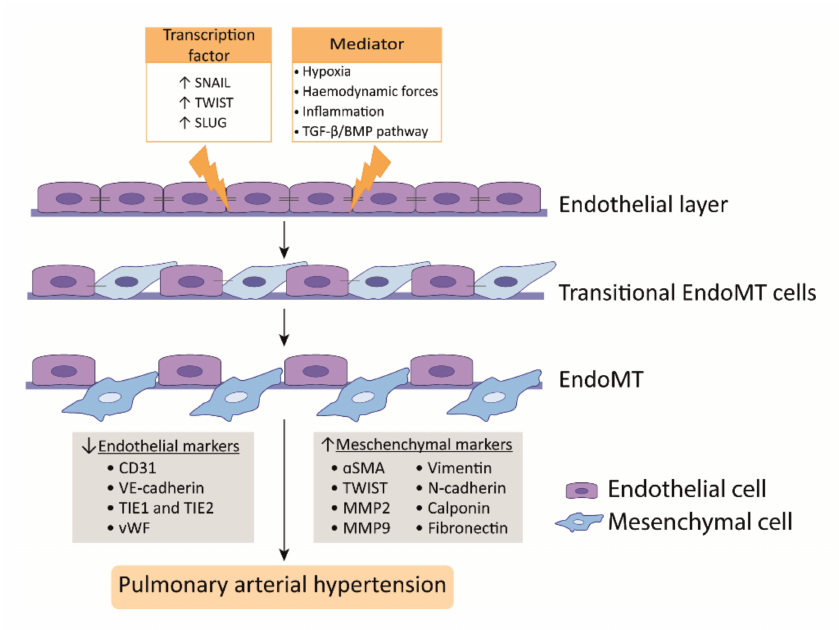
Figure 4. Endothelial to mesenchymal transition (EndoMT) in PAH. EndoMT in PAH is thought to be an important process contributing to vascular remodeling. Activation by transcriptional factors, hypoxia, haemodynamic forces, inflammation, and TGF- β /BMP pathway signaling pulmonary en- dothelial cells (PAECs) undergo cellular transition to a mesenchymal phenotype, in which PAECs lose endothelial markers and gain mesenchymal markers, such as α SMA and TWIST. These mesenchymal- like cells present an invasive character and hence contribute to vascular remodeling in